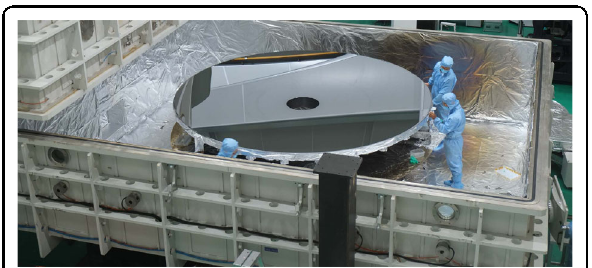
Fig. 9 ⌀ 4.03 m SiC mirror after cladding. Its surface is now ready for fi ne polishing